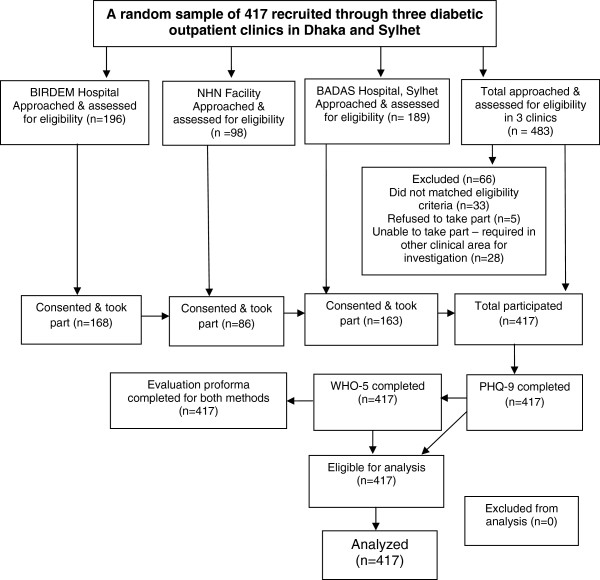
Flow participants through research study.